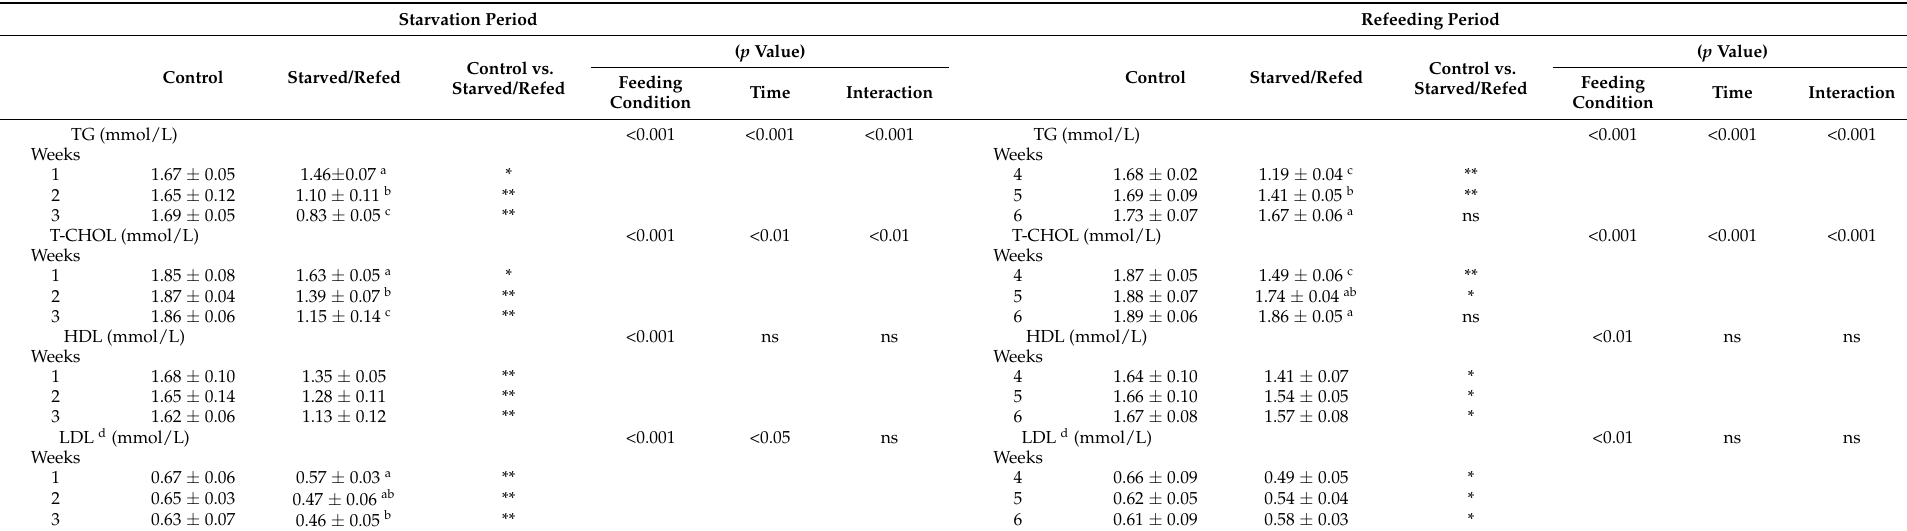
Table 4. Serum parameters of O. macrolepis exposed to starvation and refeeding